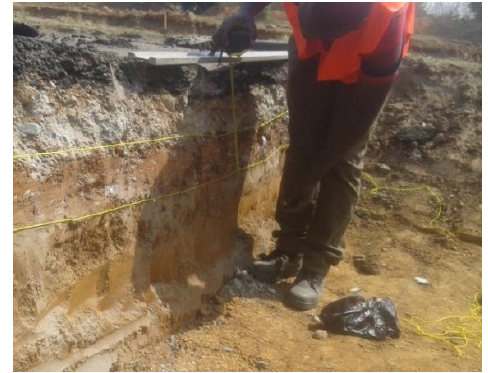
Figure 6. Profile measurements on Kitwe-Ndola Road.